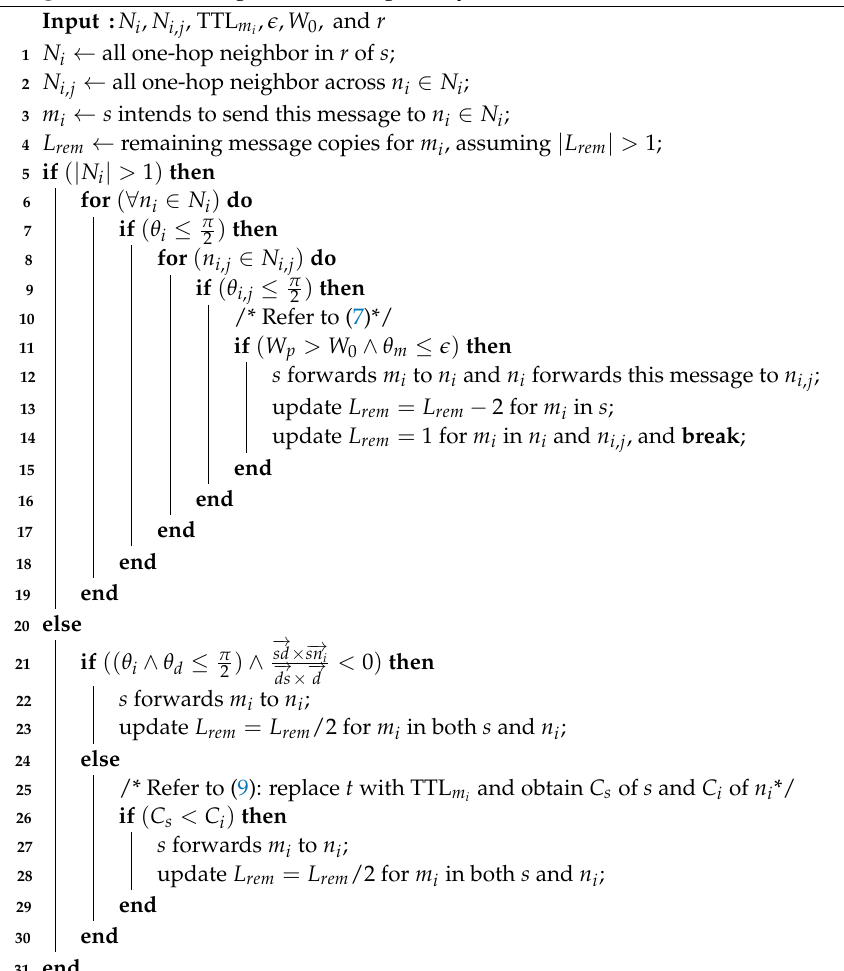
Algorithm 1: Message Forwarding